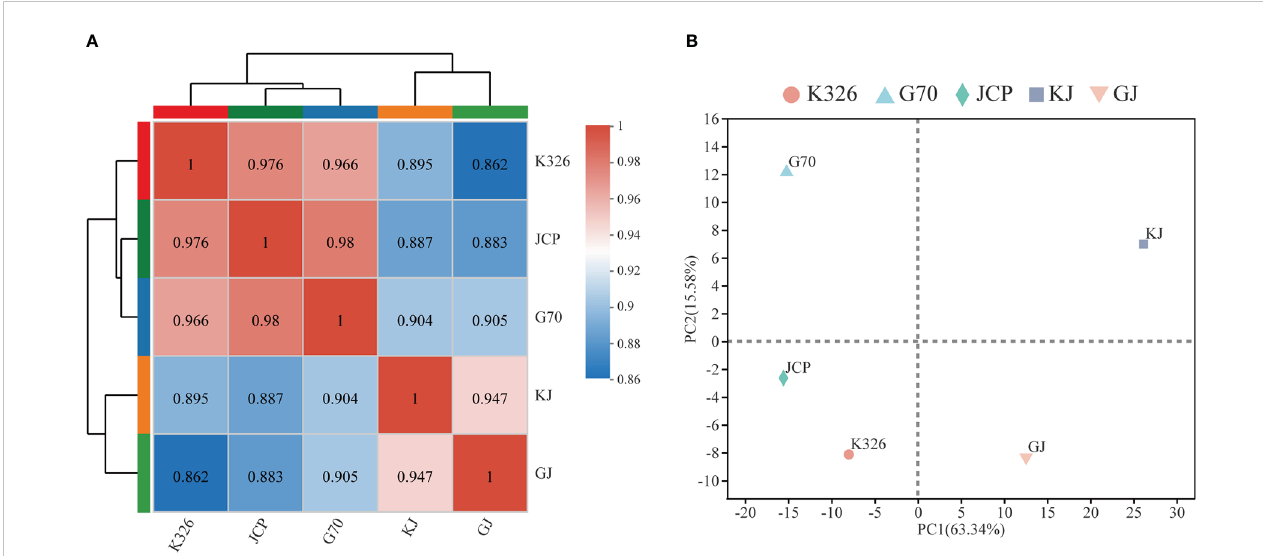
FIGURE 2 Global gene expression pro fi ling during root development. (A) Pearson correlation analysis of the two hybrids and their parents, and the color code on the right represents Pearson correlation coef fi cient. (B) Principal component analysis (PCA) of RNA-Seq data. Each point shows the average of three